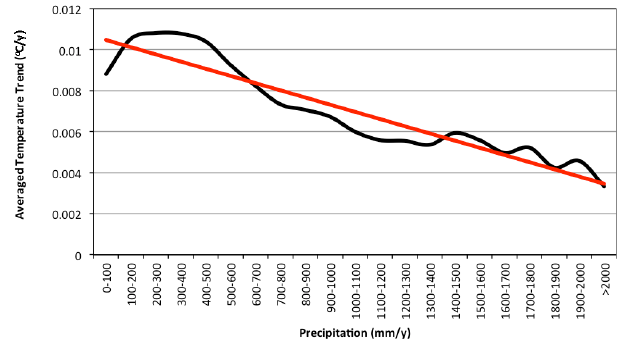
Fig. 3. The annual and regional averaged land surface linear tem- perature trend as function of climatological mean precipitation. The precipitation interval is 100mmyr − 1 .